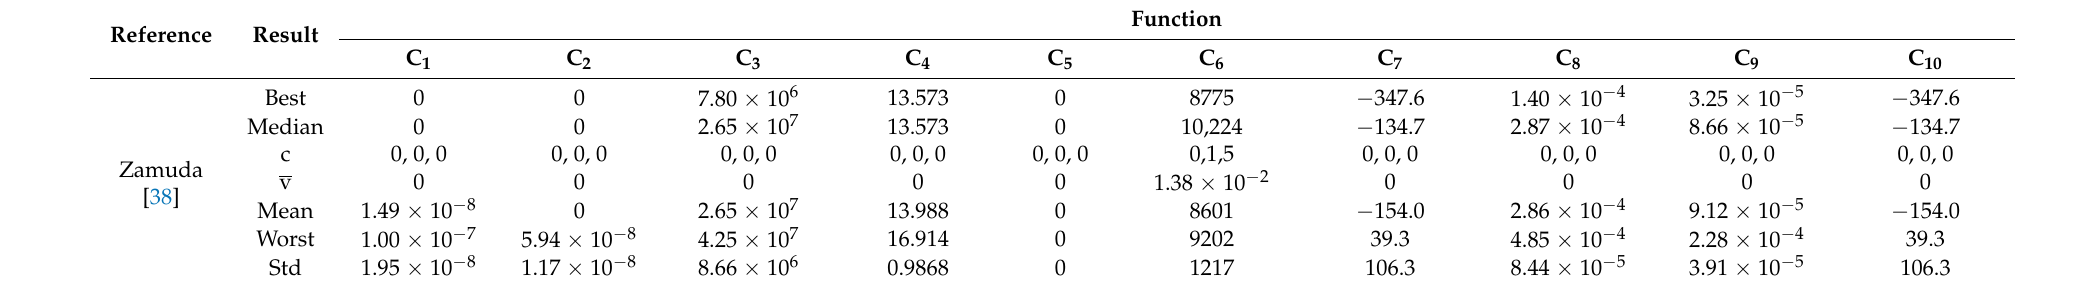
Table 6. Statistical results of different approaches for mathematical problems of CEC 2017 with 50